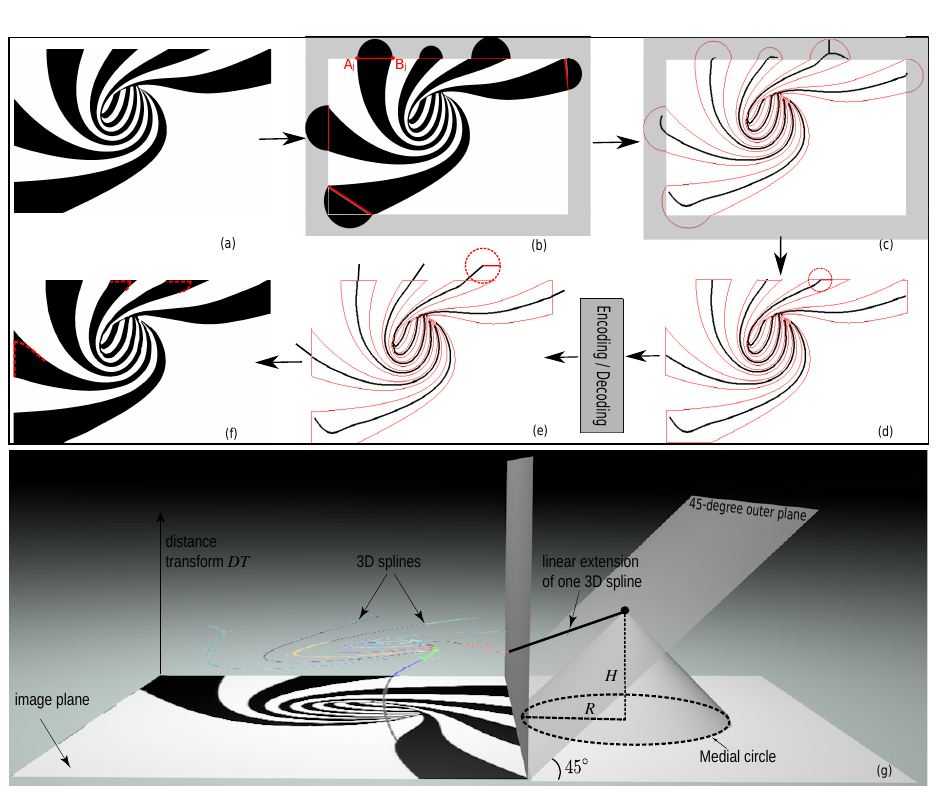
Figure 7. The pipeline of Y-structures elimination. ( a ) Layer T ↑ of the image in Figure 6. ( b ) Semi- 128 disc extension of ( a ) with diameters in red. ( c ) The contour of ( b ) (in red) and the generated MATs (in black). ( d ) The cropped MATs of ( c ). A medial circle (in red) of an endpoint of the skeletons is also drawn in ( d ). ( e ) Extending MATs that touch the image boundary. A medial circle (in red) of an extended point is also shown in ( e ). ( f ) Reconstructed layer (cid:101) T ↑ . Red dashed curves show the 128 sharp corner results when directly using the cropped MATs in ( d ). ( g ) A schematic diagram of the extension (black line segment) of one border point of the 3D MAT curves. The 45-degree outer plane of the spiral image and the generated medial circle (black dotted line) of the extended endpoint are also shown in ( g